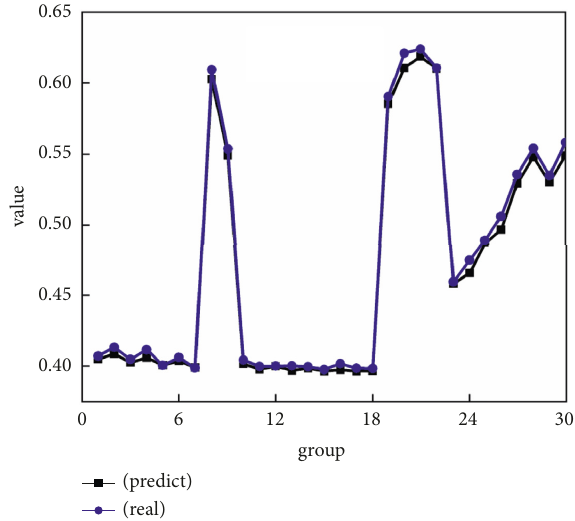
Figure 9: Predictive distribution curve of musical innovation effect